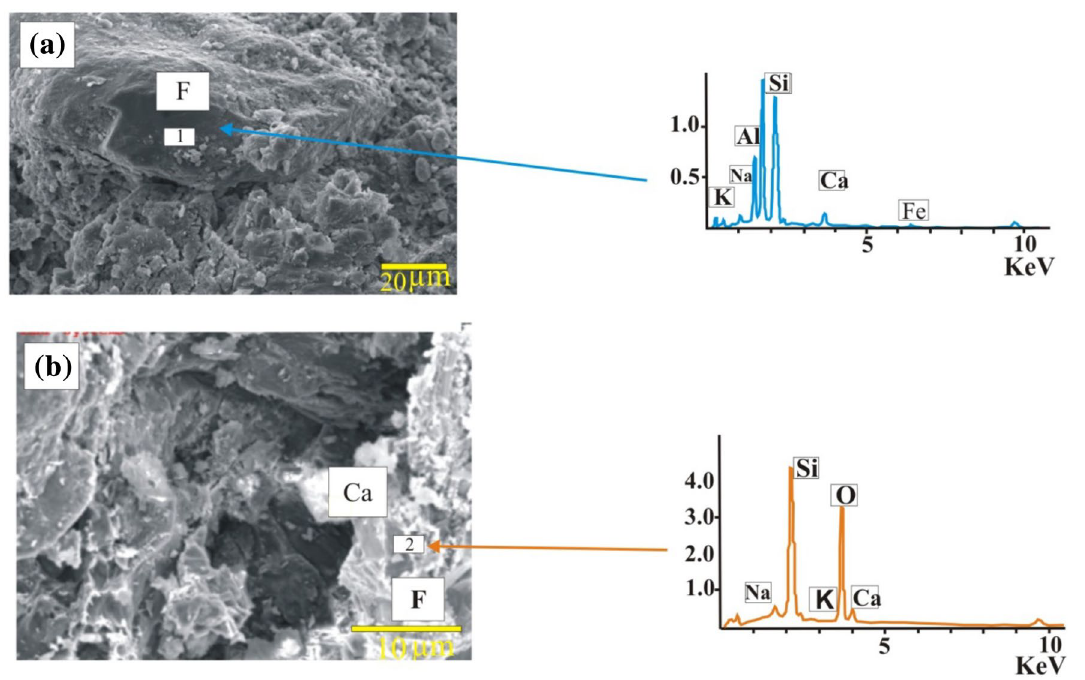
Fig. 6 Representative SEM micrographs and EDS traces for fine to medium sandstones of Kömürlü Formation. a Feldspar overgrowth (F) blocked the pore. b Feldspar overgrowth (F) and calcite (Ca) min-